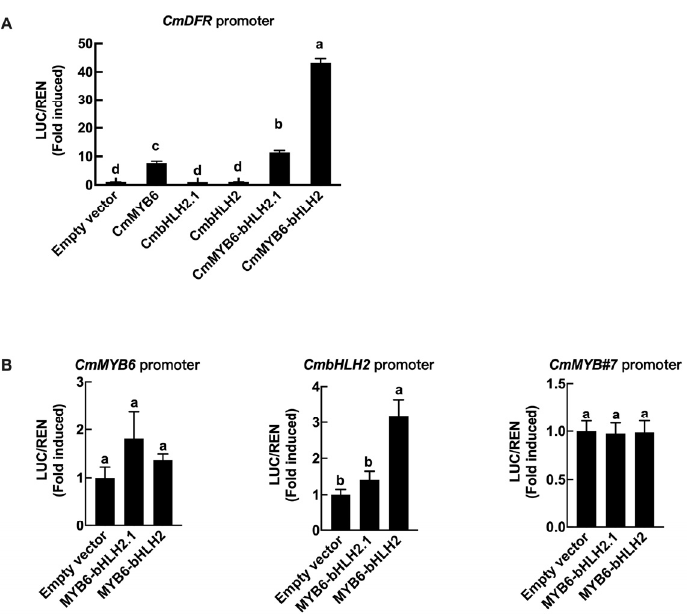
Figure 8. Regulatory effects of CmMYB6-CmbHLH2 and CmMYB6-bHLH2.1 on the CmDFR , CmMYB6 , CmMYB#7 and CmbHLH2 promoters. ( A ) Regulatory effects of CmMYB6-CmbHLH2 and CmMYB6-bHLH2.1 on the CmDFR promoter. ( B ) The regulatory effects of CmMYB6-CmbHLH2 and CmMYB6-bHLH2.1 on the CmMYB6 , CmMYB#7 and CmbHLH2 promoters. Different lowercase letters above bars represent statistically significant differences at the 0.05 probability level. Error bar indicates the SE of three independent biological replicates.